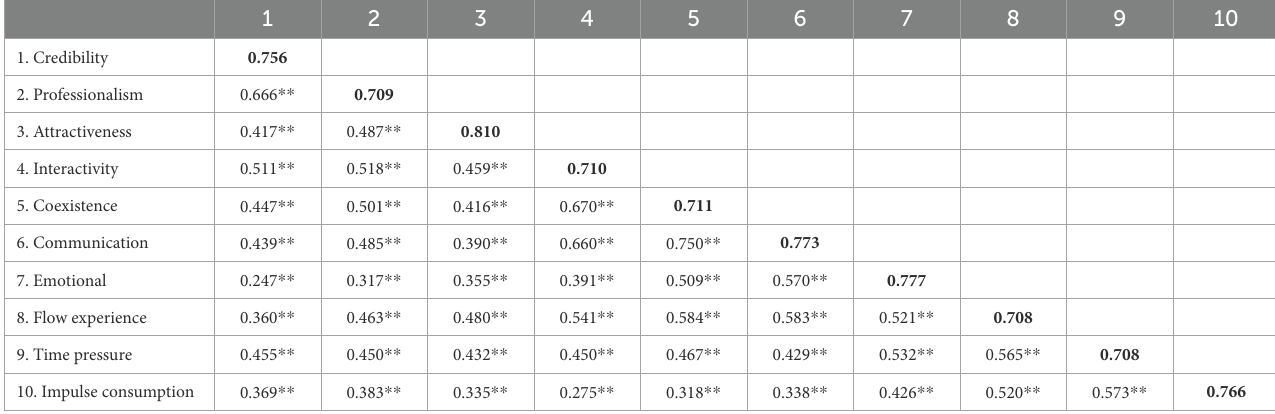
TABLE 4 Correlation matrix ( n =